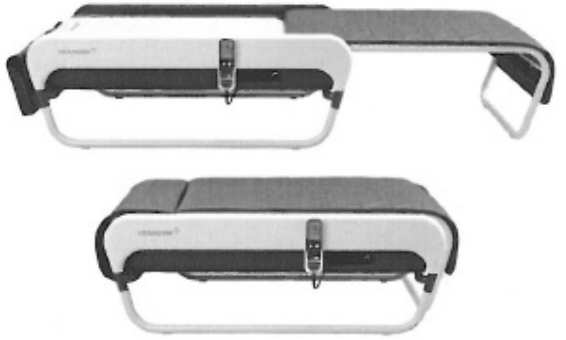
Figure 1. The heat massage device (CGM MB-1401; Ceragem, Republic of Korea).